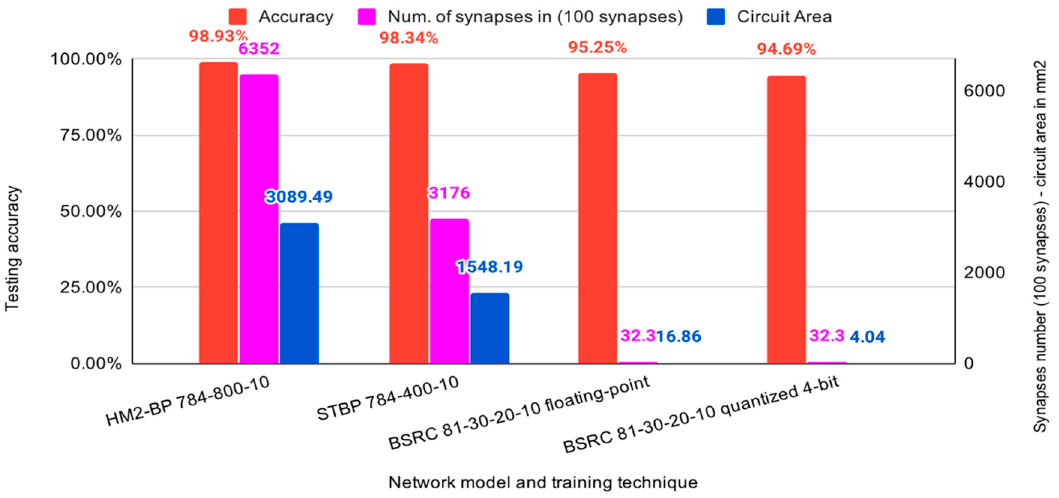
Figure 13. SNN circuit area mm 2 and accuracy using different models.